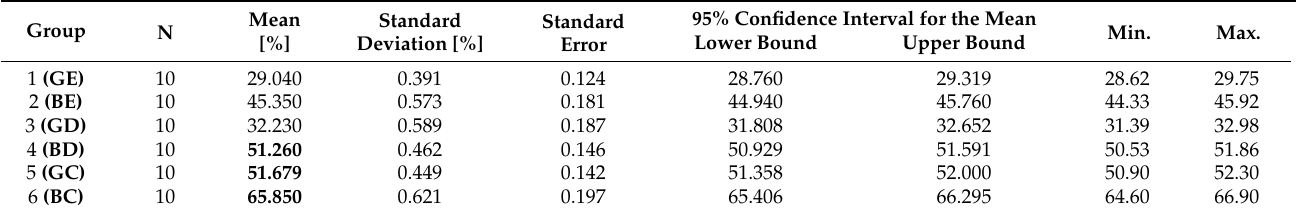
Table 1. The apparent porosity p ap [%] for the six study groups.